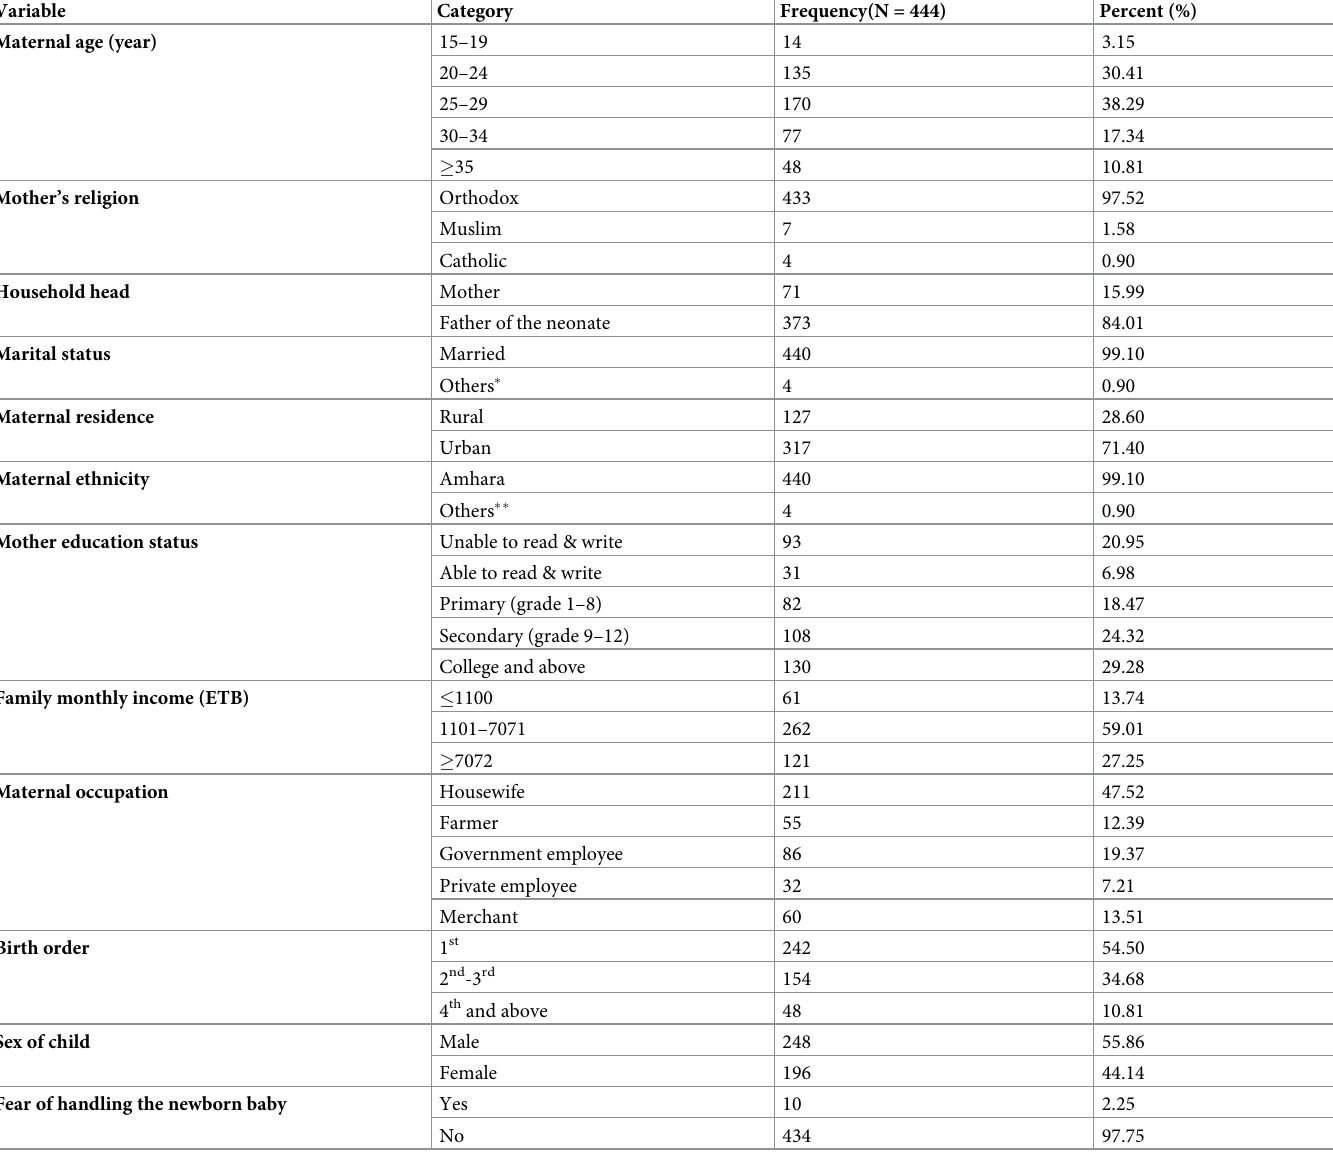
Table 2. Socio-demographic and economic characteristics among postnatal mothers within 12 hours of postpartum in Debre Markos Comprehensive Specialized Hospital, North West, Ethiopia, 2020.